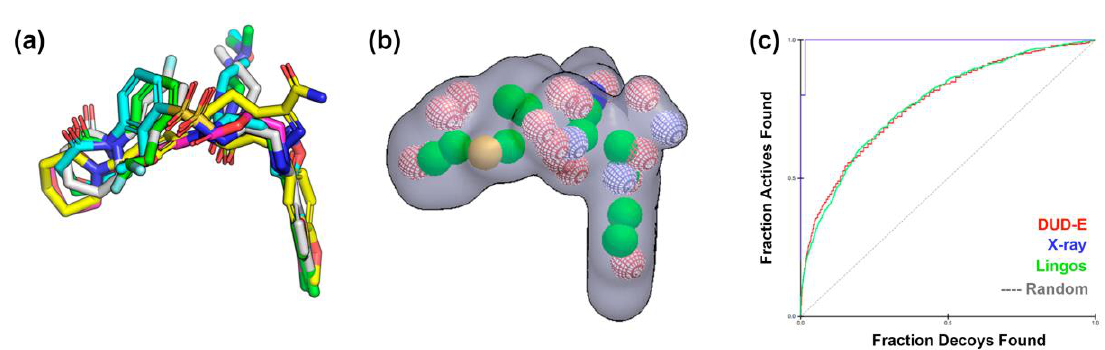
Figure 6. Shape-based query for phenyloxomorphonilo or phenyloxopiperidine containing FXa inhibitors. ( a ) Three-dimensional (3D) structural alignment of ligands after protein complexes superposition. ( b ) Shape-based query derived with color representing the combined shape with chemical features represented as spheres (hydrophobic = brown; rings = green; HB acceptor = red; HB donor = blue). ( c ) ROC area under the curve. HB: hydrogen bonding